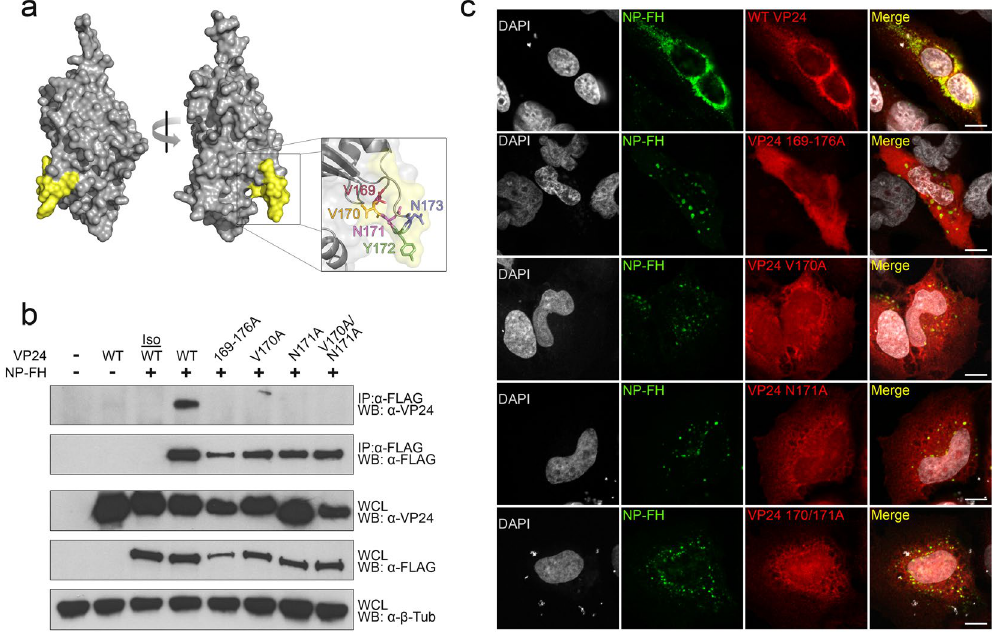
Figure 2. VP24 amino acids V170 and N171 are critical for interacting with NP. ( a ) A structural model of EBOV VP24 based on the crystal structure of Sudan and Reston virus VP24 (PDB 3VNE & 4D9O). Amino acids 169–176 are colored yellow on the surface diagram, and the inset highlights amino acids 169–173 with a ribbon and stick diagram. The arrow indicates a 90° rotation of the molecule around the Y-axis. ( b ) HEK 293 cells were co-transfected with pCAGGS-NP-FH and pCAGGS-Wild-type (WT) VP24 or a VP24 point mutant: pCAGGS-VP24 169–176A, pCAGGS-VP24 V170A, pCAGGS-VP24 N171A, or pCAGGS-VP24 V170A/ N171A. Lysates were immunoprecipitated with mouse anti-FLAG or isotype control (Iso) antibodies, and immunoprecipitation (IP) and whole cell lysate (WCL) fractions were subjected to Western blot (WB) with mouse anti-FLAG, rabbit anti-VP24, or rabbit anti- β -tubulin antibodies. IP/Western blot data are representative of at least three independent experiments. Western blots were cropped for presentation; full-length blots are available in Supplementary Fig. 7. ( c ) Hela cells were co-transfected with pCAGGS-NP-FH and pCAGGS- Wild-type (WT) VP24 or a VP24 mutant: pCAGGS-VP24 169–176A, pCAGGS-VP24 V170A, pCAGGS-VP24 N171A, or pCAGGS-VP24 V170A/N171A. Following fixation and permeabilization, cells were stained with mouse anti-FLAG and rabbit anti-VP24 antibodies prior to staining with AlexaFluor 488 goat anti-mouse and AlexaFluor 546 goat anti-rabbit secondary antibodies. Coverslips were mounted with ProLong Gold Antifade Mountant containing DAPI to visualize the nuclei. Note that the extranuclear DAPI staining is an occasional artifact of transfection. White scale bars represent 10